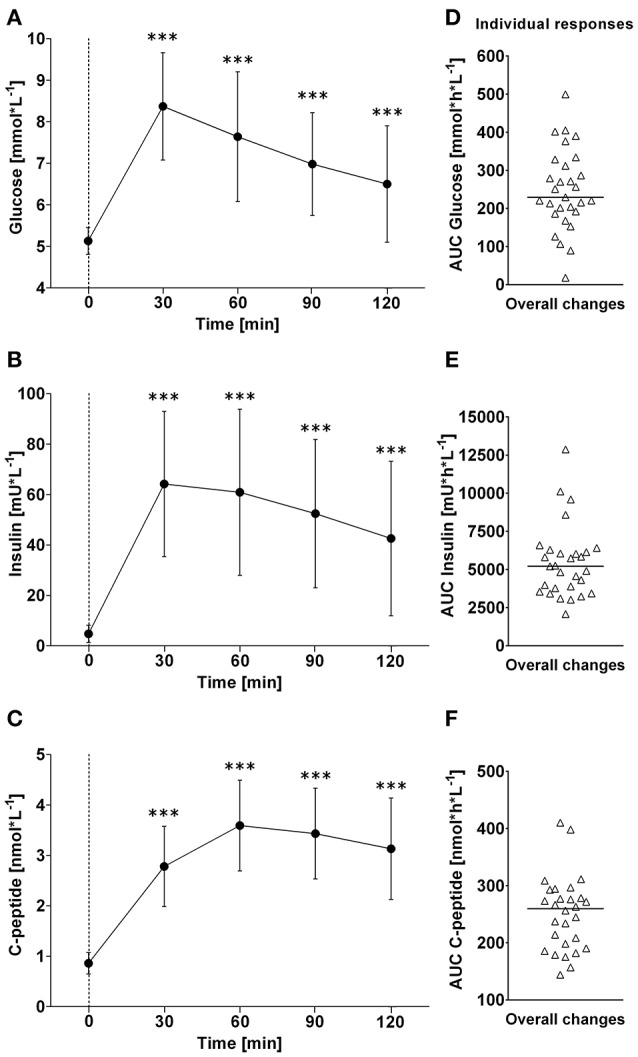
(A–C): Time course of changes (Δ) from baseline in blood glucose, insulin and C-peptide levels, respectively. Closed circles (•) represent averaged data from the respective blood-draw interval, i.e., at baseline, which is denoted as 0, and every 30 min thereafter up to 120 min. (D–F) Represent area under curve analysis using the trapezoid method for glucose (D), insulin (E) and C-peptide (F). ***P < 0.005 represents statistically significant differences over time compared to baseline values (left). (A–C) Values are reported as means ± SD, whilst (D–F) data are presented as a scatter dot plot with a median (bold horizontal dashed line).